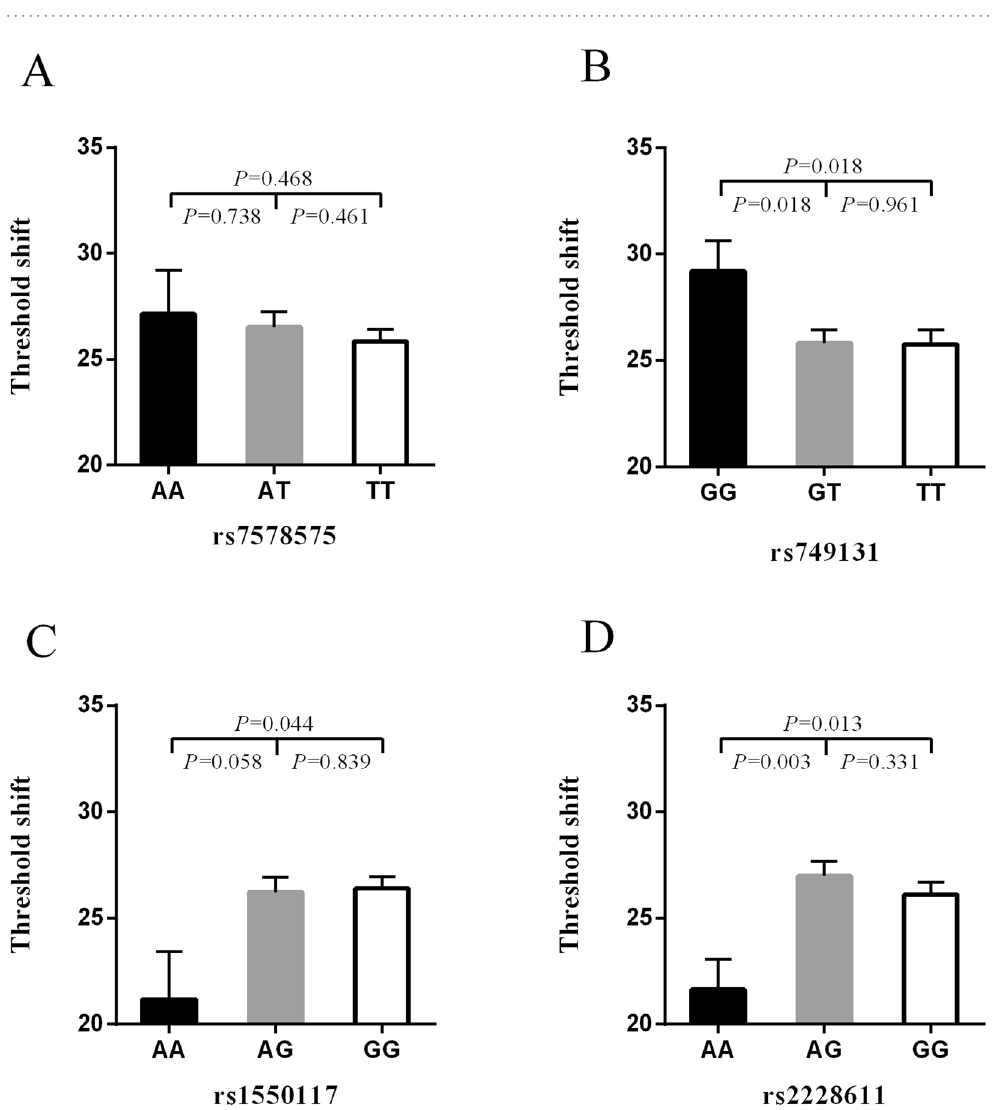
Figure 1. Comparison of high-frequency hearing threshold shift of all subjects. Comparison of high-frequency hearing threshold shift of rs7578575 ( A ), rs749131 ( B ), rs1550117 ( C ) and rs2228611 ( D ) genotypes in all subjects. Data are presented as mean ± SE and analyzed by ANOVA.